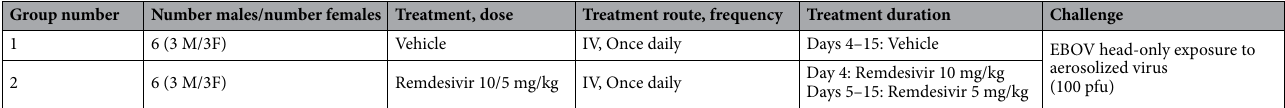
Table 1. Study design. EBOV Ebola virus, F female, IV intravenous, M male, pfu plaque-forming units, PI post-inoculation (with